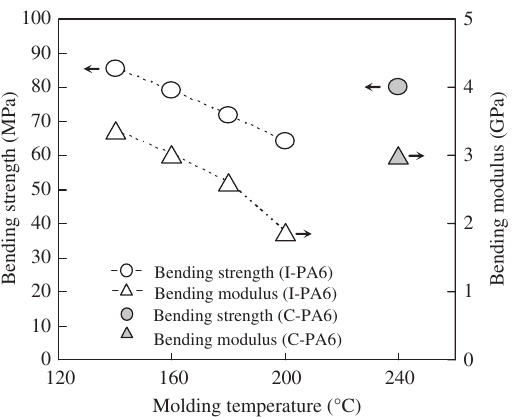
Figure 13 Bending strength of I-GFRTP and C-CFRTP for molding temperature.